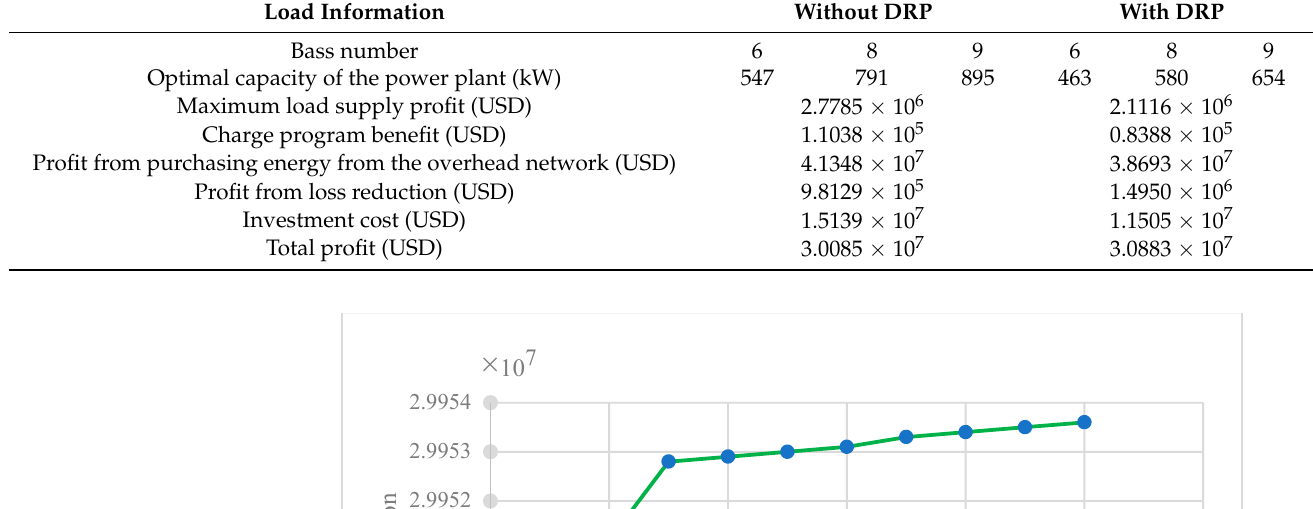
Table 6. Simulation results for the location of three electric vehicle parking lots.